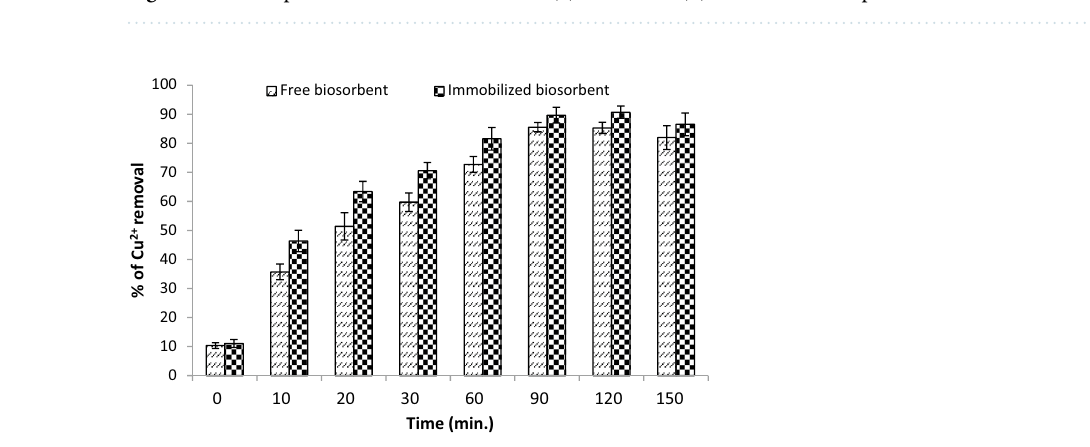
Figure 8. FTIR spectra of R. damascena leaves ( a ) before and ( b ) after Cd 2+ biosorption.